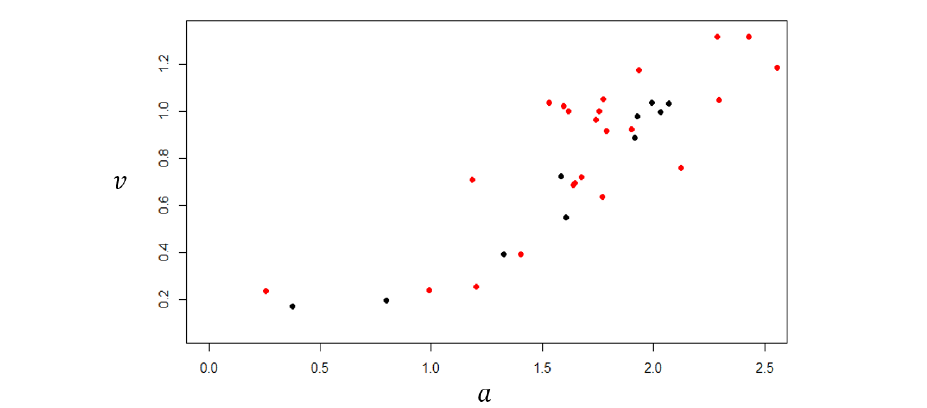
Figure 6. Area of maximum concentration of positive